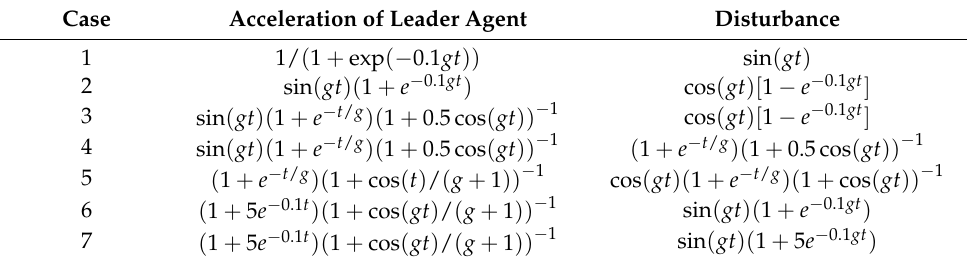
Table 1. Acceleration of leader agent and disturbance used for data generation.